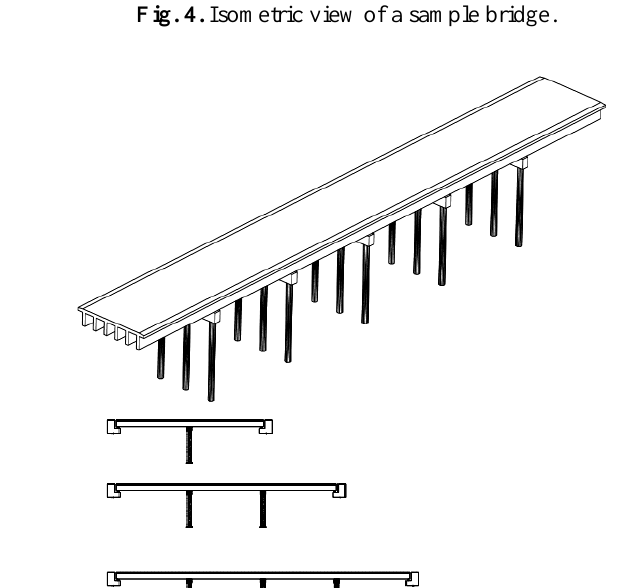
Fig. 4. Isometric view of a sample bridge.